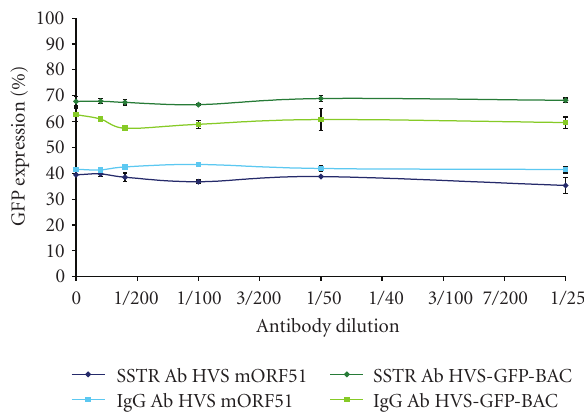
Figure 12: SSTR antibody fails to neutralise HVS mORF51 infection. Huh7.5 cells were incubated with antibody (SSTR or mouse IgG negative control) for 1h prior to infection with HVS- GFP-BAC or HVS mORF51. Samples were then measured for GFP expression using flow cytometry 48h after infection ( n = 2). Antibody concentration had no e ff ect on either virus infection suggesting that SSTRs are not required for HVS mORF51